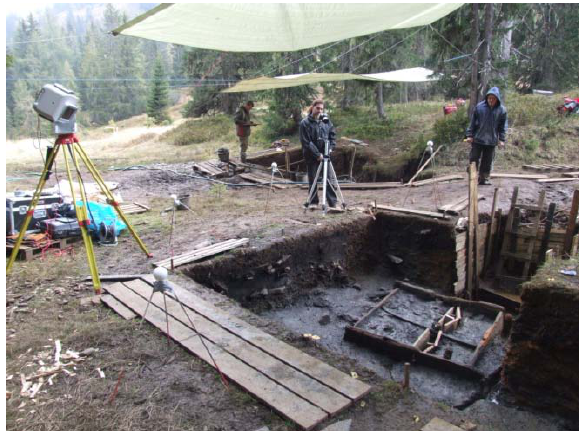
Figure 2. Data collection at the archaeological site with different survey